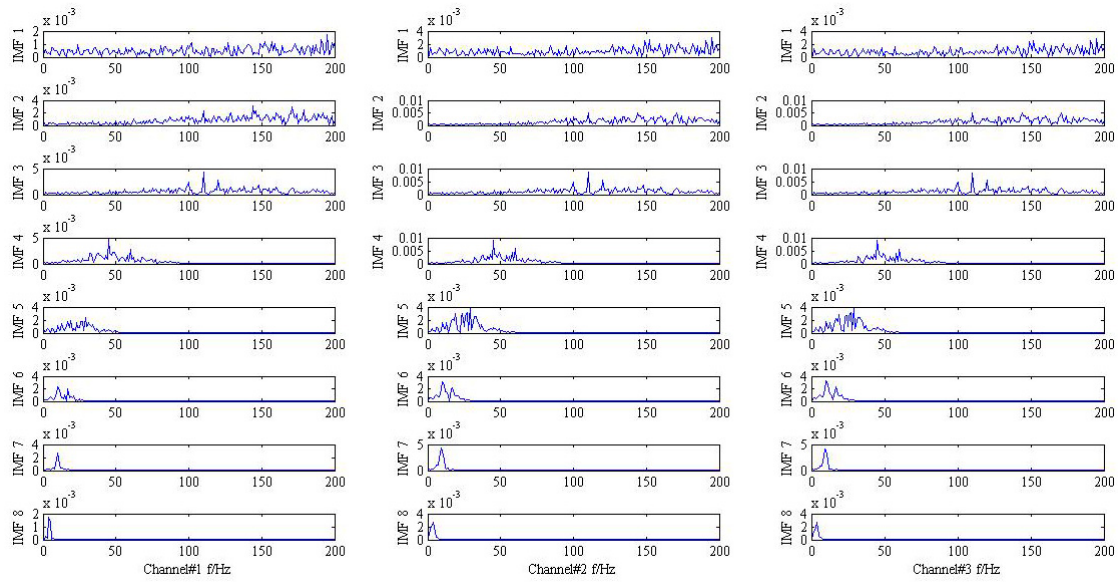
Figure 4. The result provided by the proposed method.